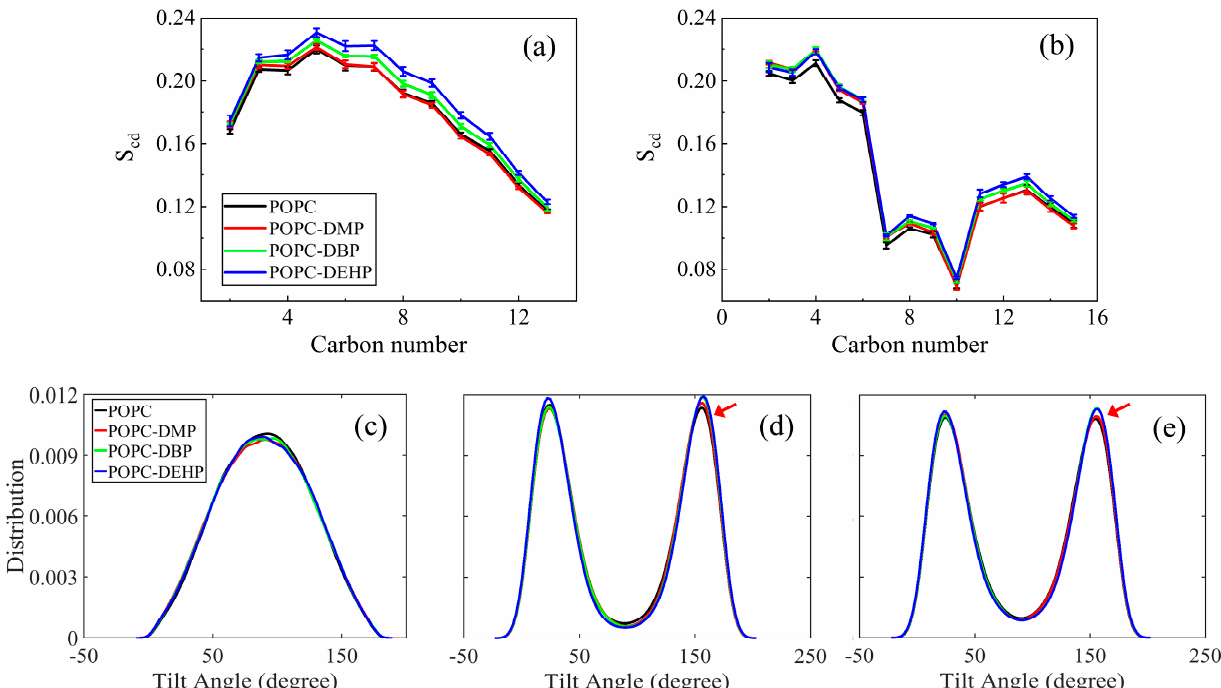
Figure 5. The effects of DMP, DBP, and DEHP on the conformation and orientation of lipid tails and P-N vector. ( a , b ) Deuterium order parameters (S cd ) of lipid tails for sn-1 and sn-2, respectively. ( c – e ) Distribution of tilt angles of the P-N vector, sn-1 and sn-2, respectively. The tilt angle for sn-1 and sn-2 is defined by the vector of the first and last carbons of the acyl chains with respect to the z axis of the bilayer.